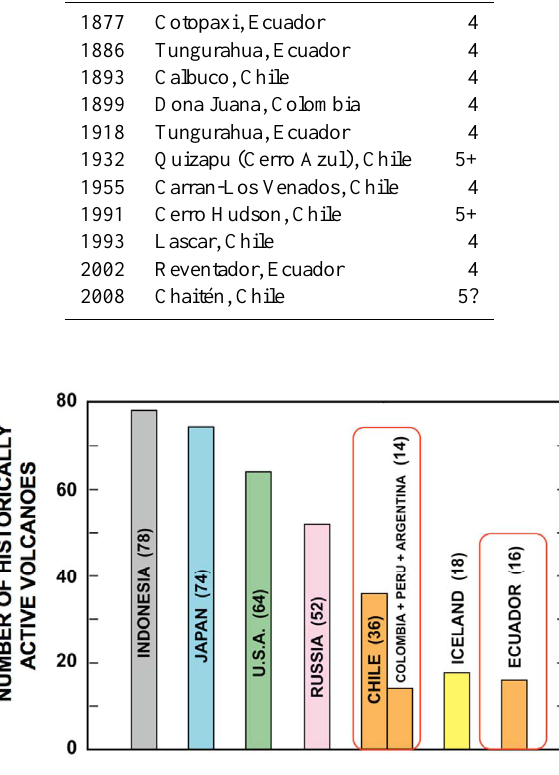
Histogram of historically active volcanoes grouped by country; the numbers in parentheses indicate the number of individual volcanoes. The Andean countries combined (highlighted by red outlines) host 66 of the ~ 550 historically active volcanoes worldwide. [Primary data source: Simkin and Siebert, 1994).